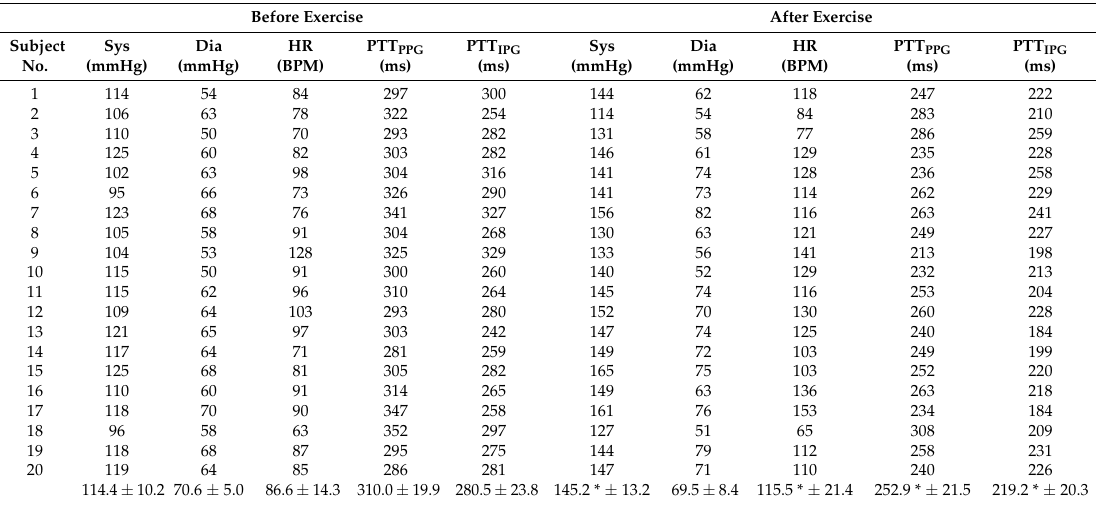
Table 3. In the second test, the measurement parameters before and after exercise.